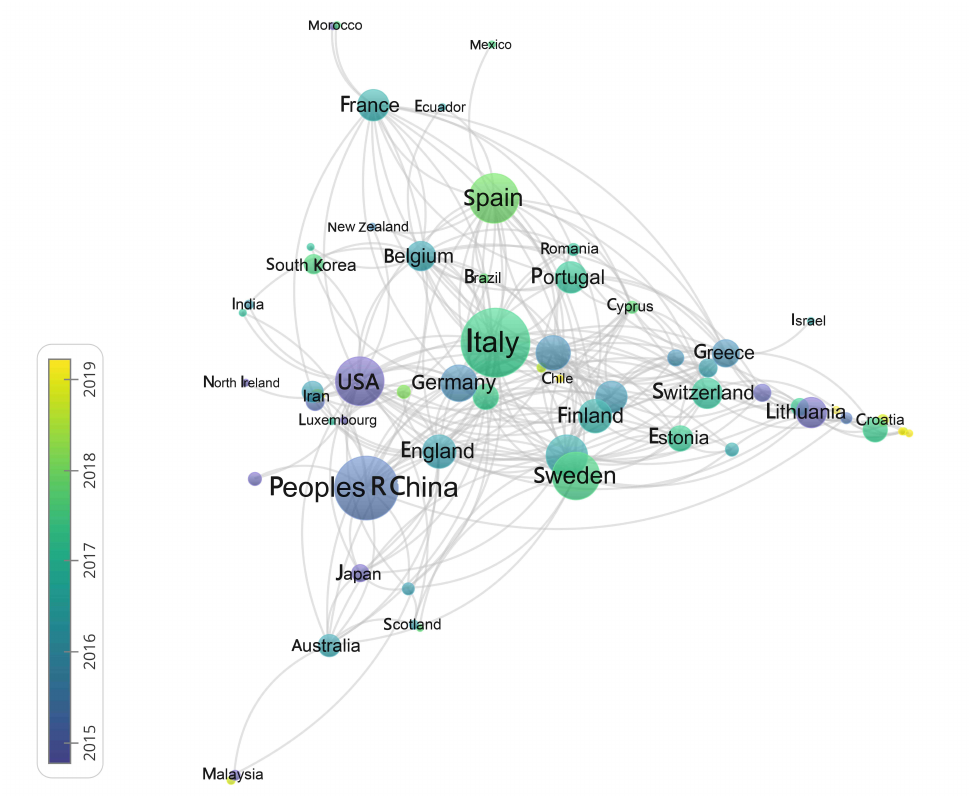
Figure 6. National cooperation of